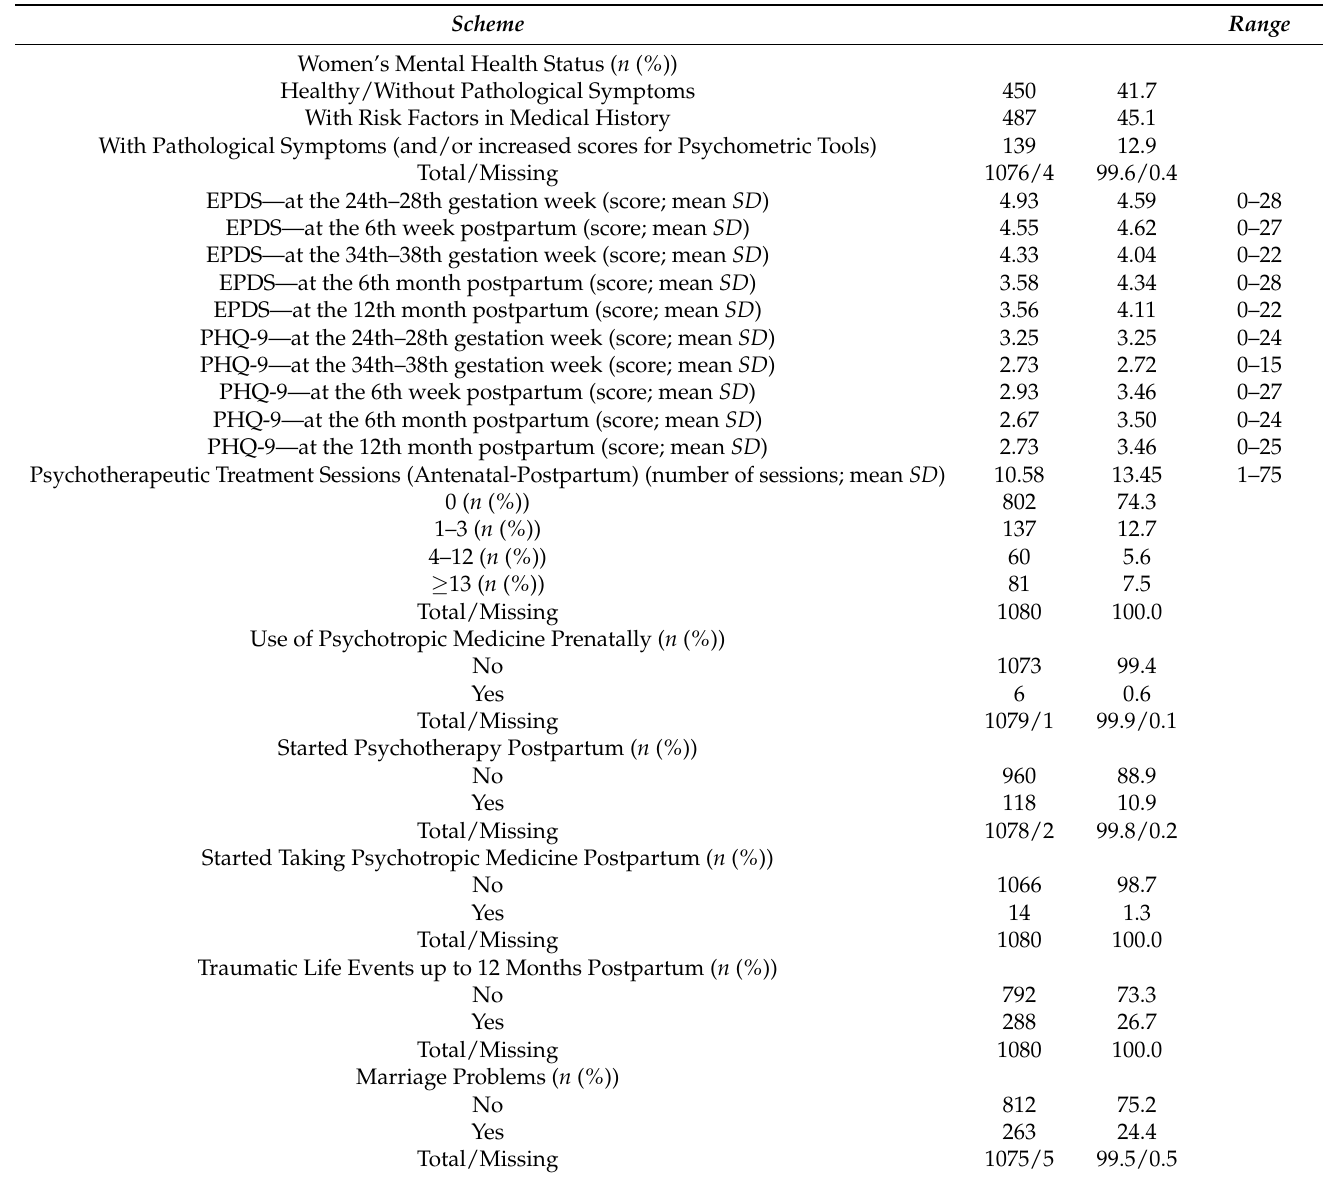
Table 2. Women’s mental health characteristics in the current perinatal period.